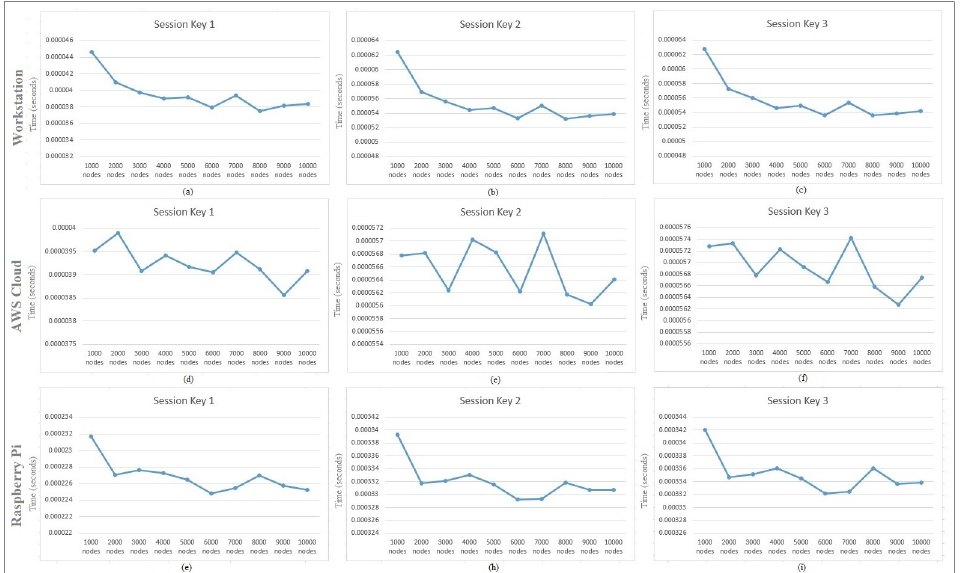
Figure 5. Session key generation time on the workstation for ( a ) Session Key 1, ( b ) Session Key 2,